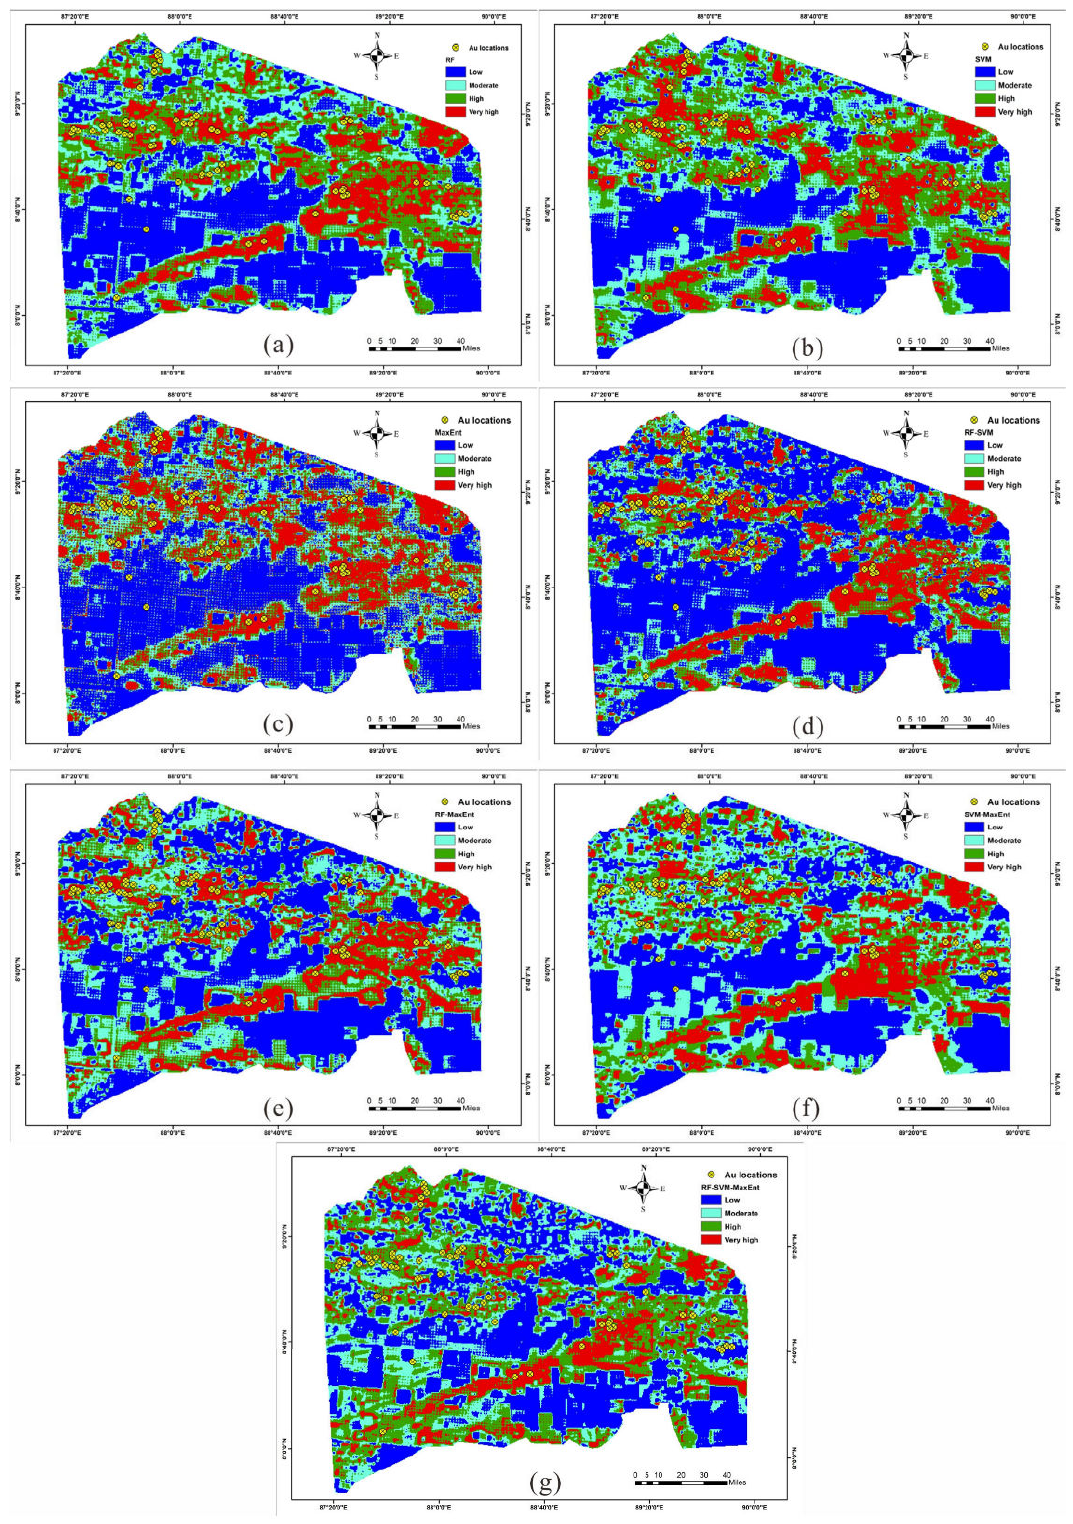
Figure 7. Mineral prospectivity maps by di ff erent methods: ( a ) RF; ( b ) SVM; ( c ) MaxEnt; ( d ) RF–SVM; ( e ) RF–MaxEnt; ( f ) SVM–MaxEnt; ( g )